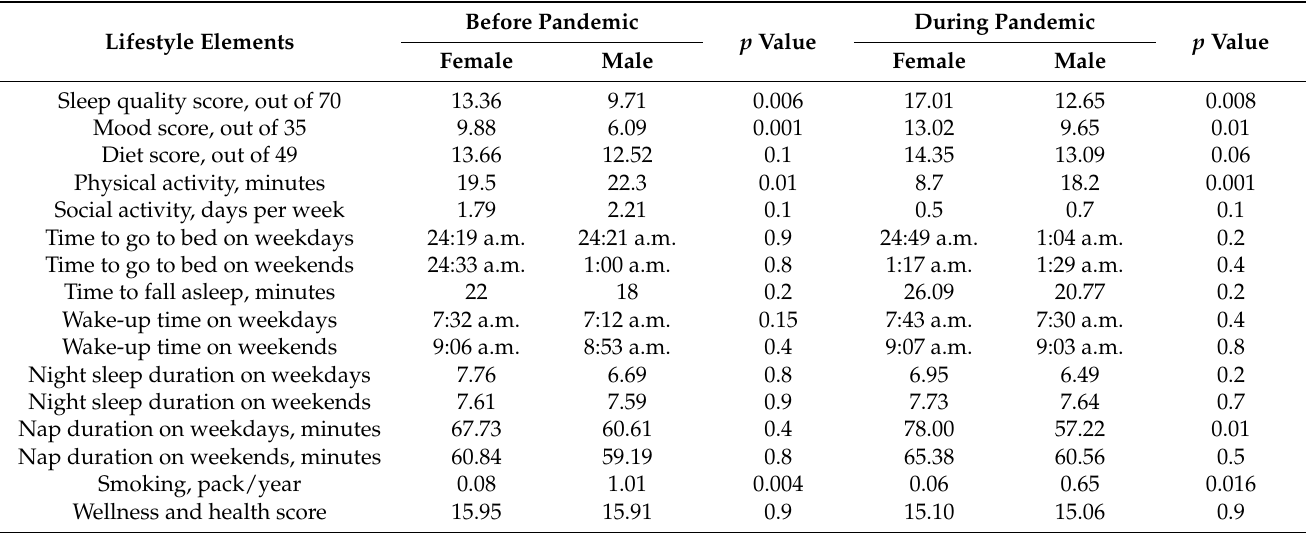
Table 3. Lifestyle characteristics of participants comparing females and males in the pandemic and pre-pandemic periods.